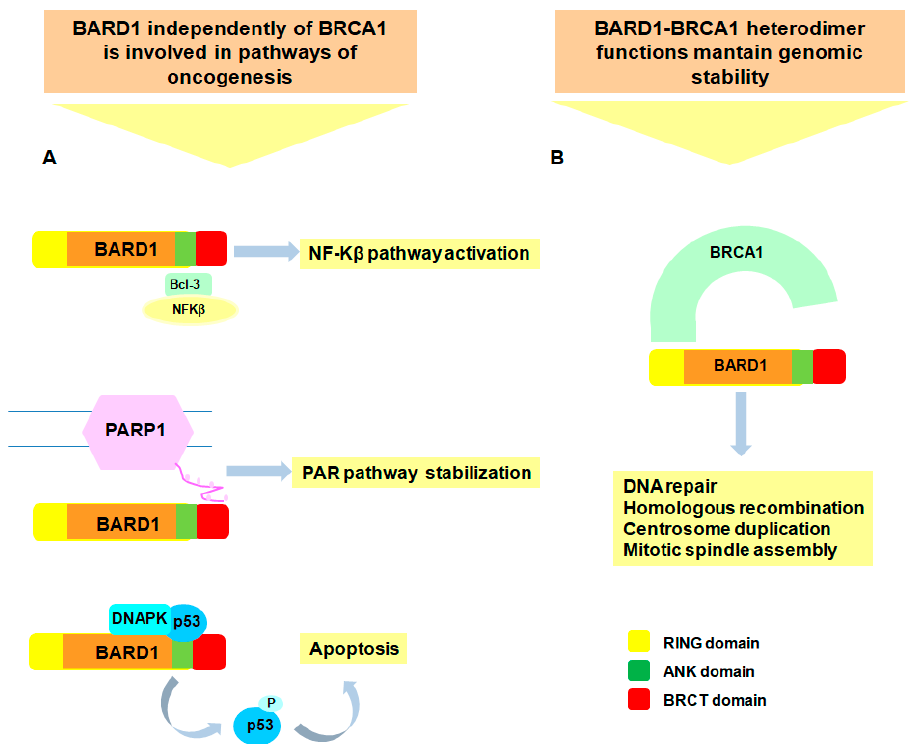
Figure 3. Full-length (FL) BARD1 pathways and functions. FL BARD1 participates in two major pathways as tumor suppressor. ( A ) BRCA1-independent pathways are mediated by the interaction of BARD1 with proteins involved in oncogenic pathways. BARD1 has transcriptional activity as it can induce the transcription activity of NF- κ Bs through binding to the NF- κ B co-factor BCL3